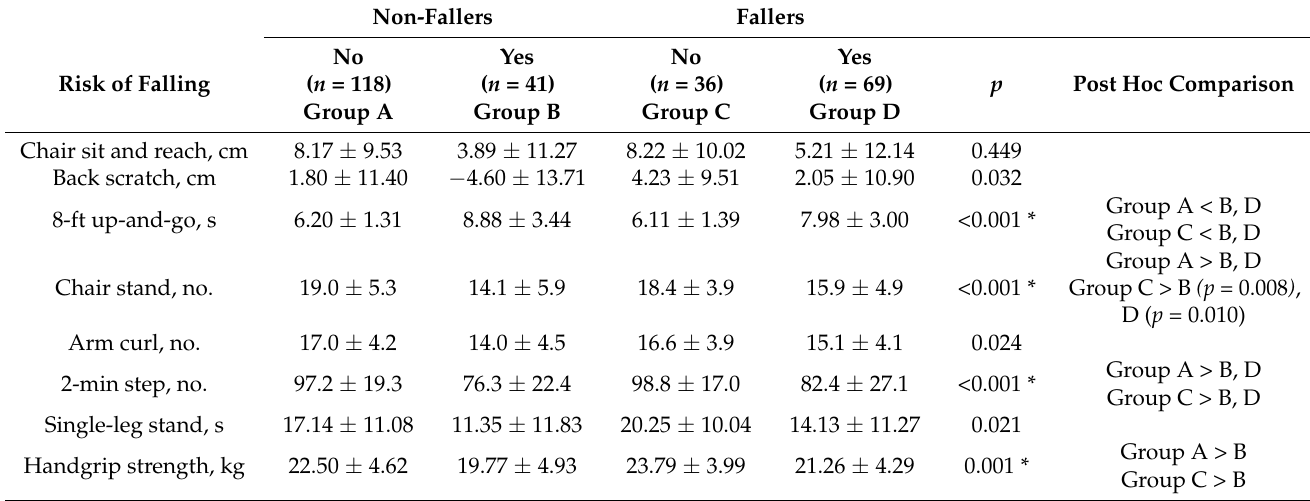
Table 2. Comparisons of physical fitness between community-dwelling elderly women fallers and non-fallers with and without a risk of